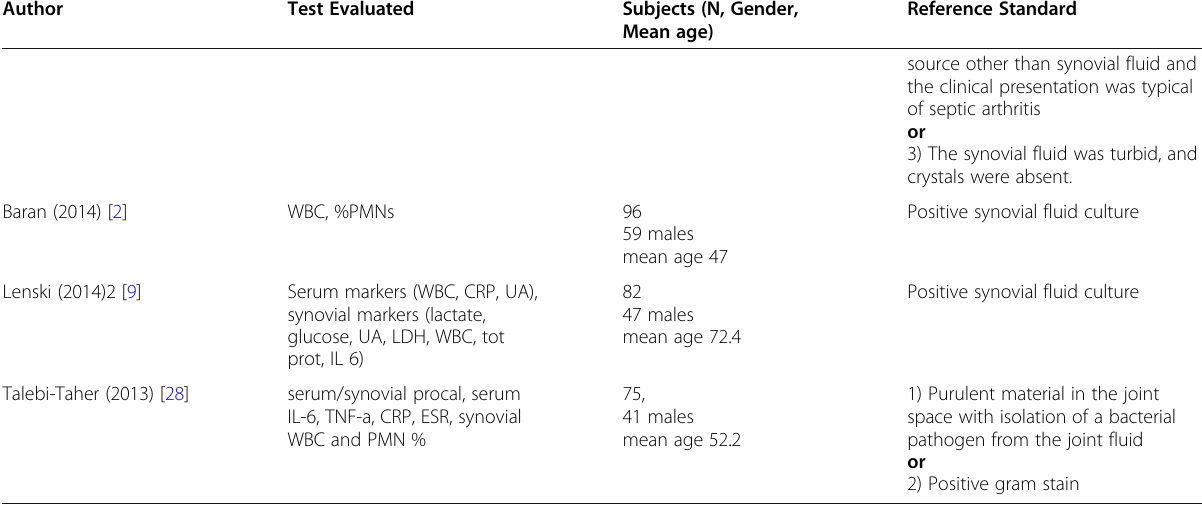
Table 1 Characteristics of Included Studies (Continued)